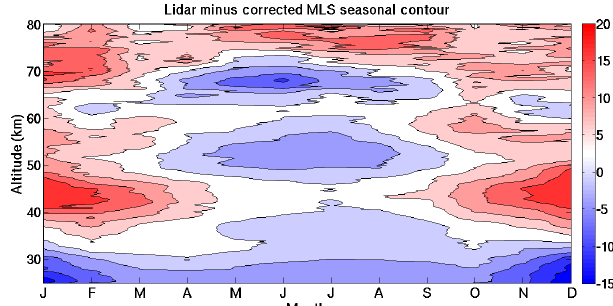
Figure 13. Corrected seasonal temperature differences between the lidar and the vertically displaced MLS temperatures. The structured nature of the temperature bias seen in Fig. 6 remains unchanged by the vertical